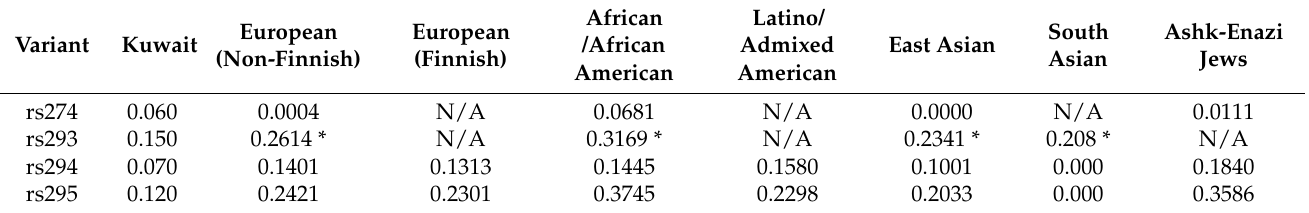
Table 10. Comparison of minor allele frequencies (MAF) of LPL rs274, rs293, rs294, and rs295 across different